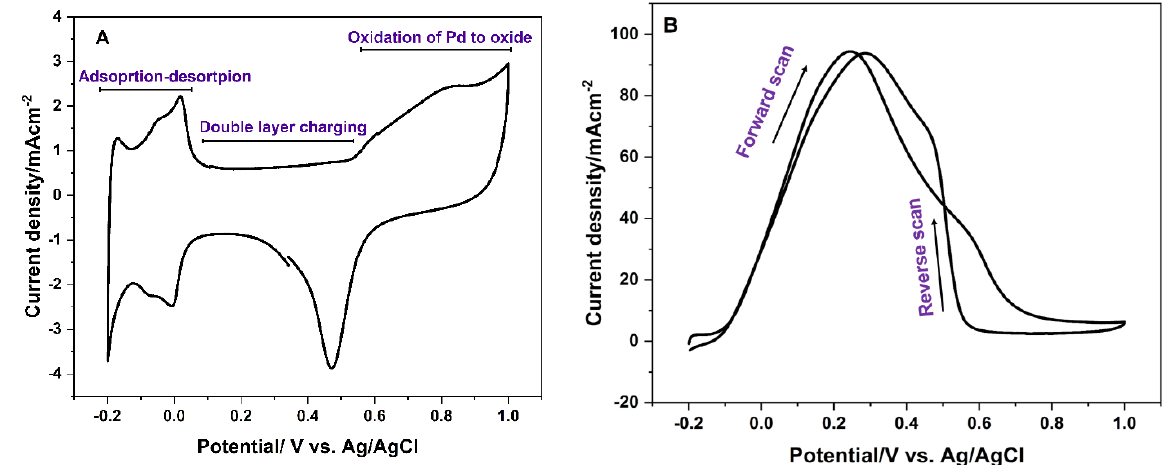
Figure 6. Cyclic voltammetry curves for Pd 1 Co 1 /N-rGO in ( A ) 0.5 M H 2 SO 4 solution and ( B ) 0.5 M H 2 SO 4 + 0.5 M HCOOH in solution at scan rate 20 mv s –1 .